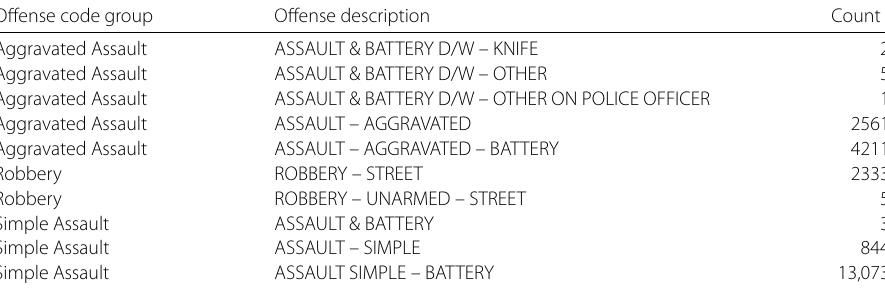
Table 5 Summary statistics for selected crime events in the study area Offense code